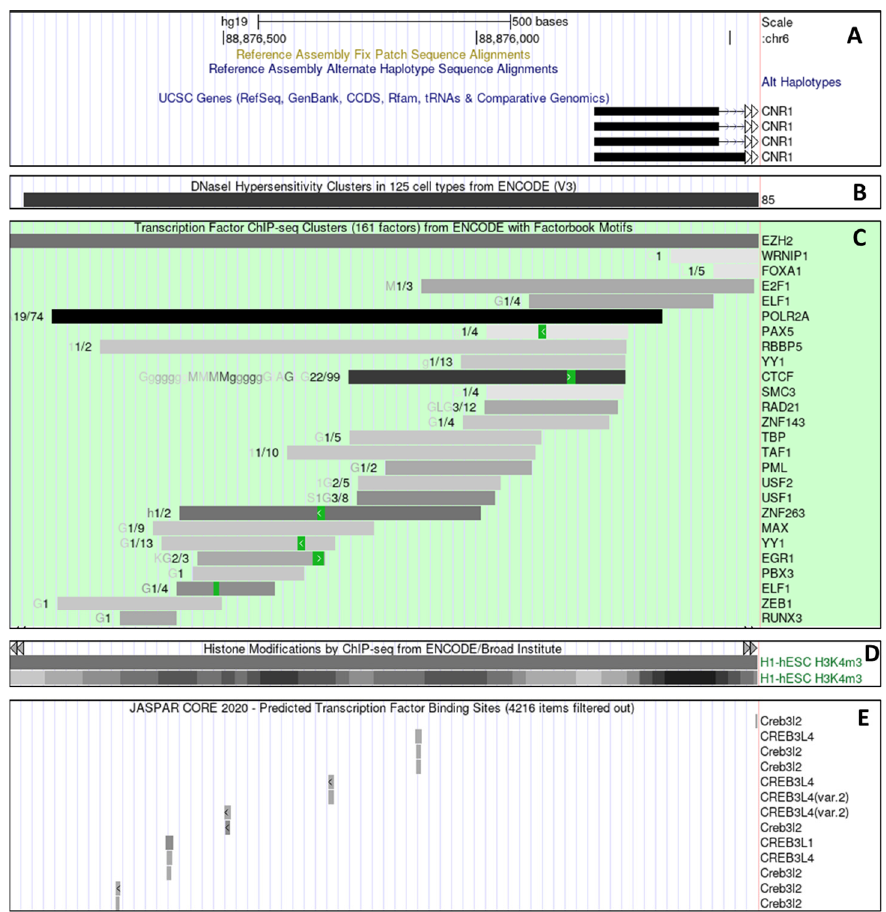
Figure 5. Genomic annotation of CNR1prom sequence. Genomic datamining analysis from the UCSC genome database demonstrating ( A ) 1 kb of genomic DNA 5 ′ of the human CNR1 locus with the CNR1 exon 1 shown as a black bar and intron 1 shown as a thin line with chevrons. ( B ) The results of DNAse1 hypersensitivity assays (Black bar) from 125 cell lines demonstrating open chromatin extending approximately 800 bp 5 ′ from the CNR1 transcription start site. ( C ) The results of multiple CHIP-seq analyses on different cell lines demonstrating the binding of different transcription factors and RNA polymerase II (POLR2A) to the CNR1 promoter region. ( D ) ChIP-seq analysis of modified histone (H3K4me3) highlighting promoter activity. ( E ) Predicted binding sites (Grey boxes) for the CREB transcription factor as calculated by JASPAR.